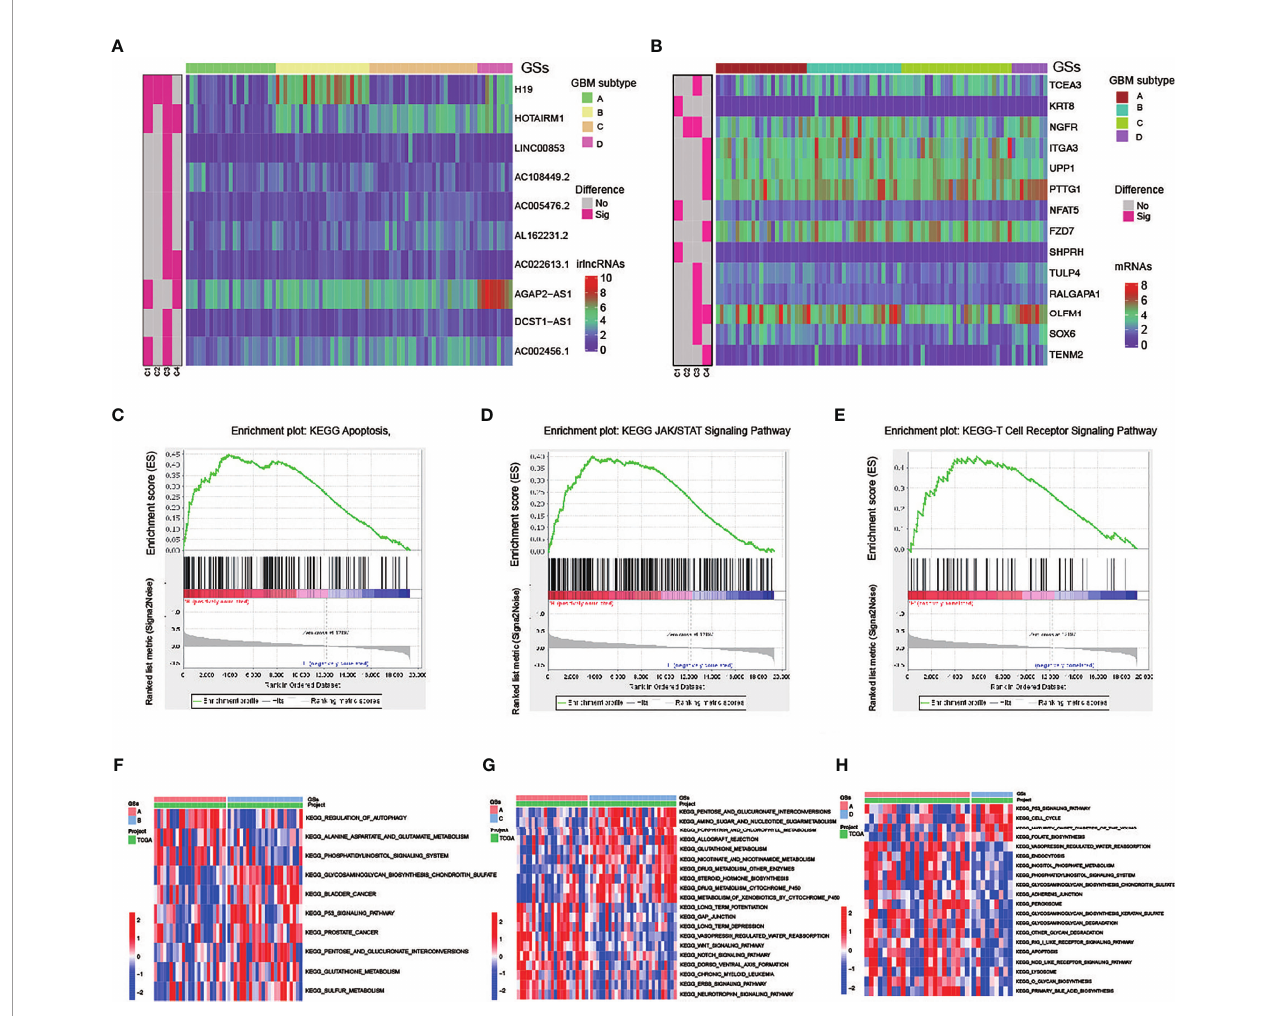
FIGURE 6 | Molecular difference analysis of four GBM subtypes (A, B) Heatmaps of 10 differentially expressed irlncRNAs (A) and 14 mRNAs (B) between the 4 GBM subtypes. (C – E) GSEA showing that the functional pathways involved in RKT8 were mainly immune cell- and tumor-related signaling pathways. (F – H) GSVA enrichment analysis showing the activation states of biological pathways in